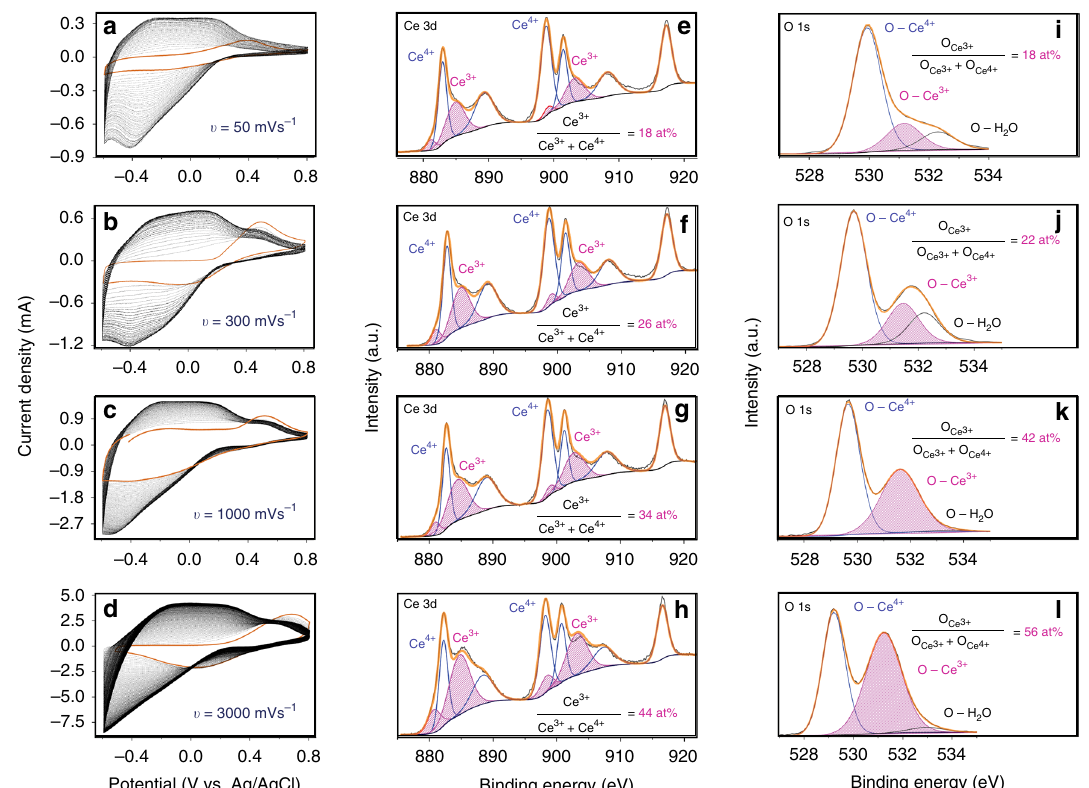
Fig. 5 Proton-assisted control of oxygen vacancy formation during cyclic voltammetry. Cyclic voltammograms at scan rates: a 50 mV s -1 . b 300 mV s -1 . c 1000 mV s -1 . d 3000 mV s -1 . e – h Corresponding XPS Ce 3 d spectra. i – l Corresponding XPS O 1 s